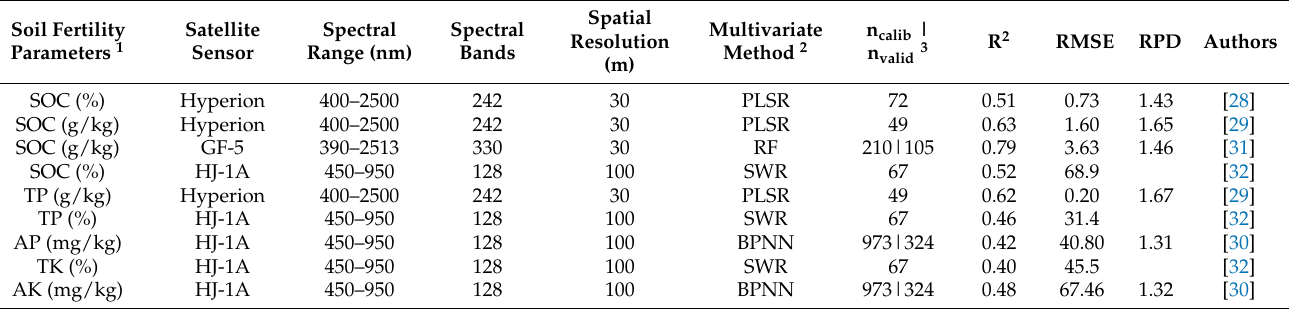
Table 1. A review of the literature comparing quantitative predictions of various soil fertility parame- ters at a regional scale using hyperspectral satellite remote